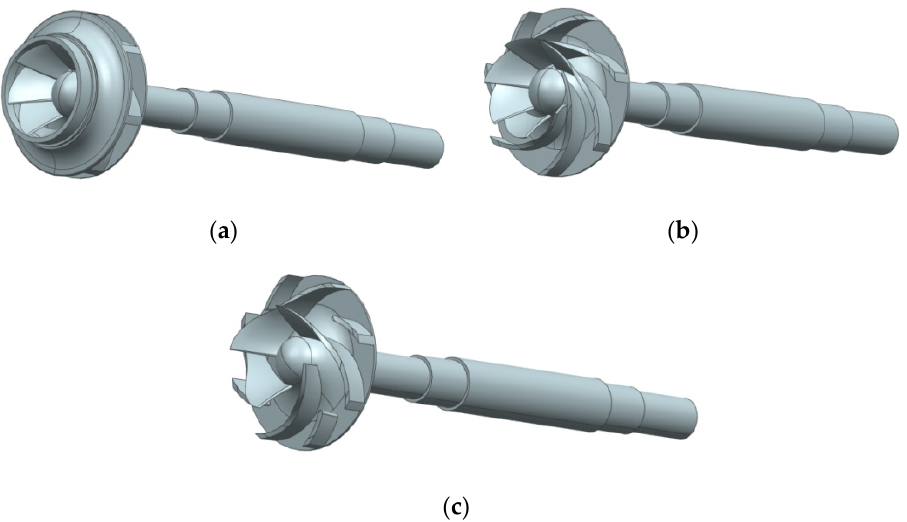
Figure 3. Different impeller rotor structures of the centrifugal pump: ( a ) Case A impeller, ( b ) Case B impeller, and ( c ) Case C impeller.